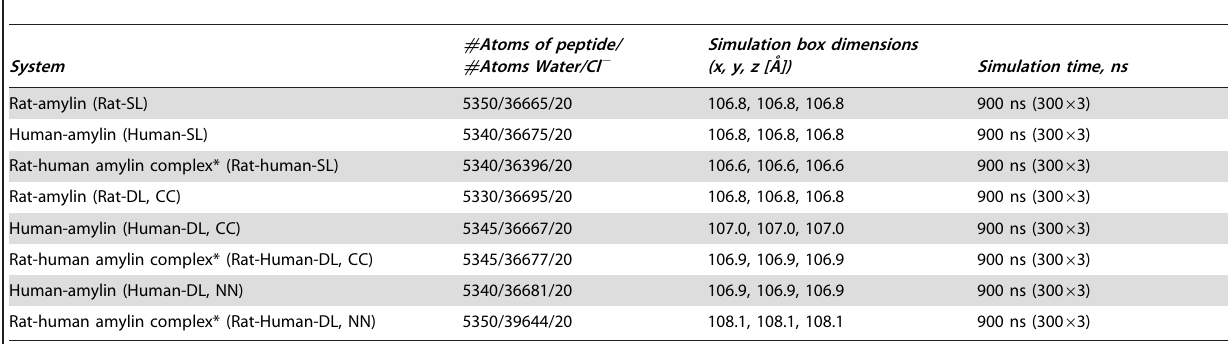
Table 1. Single layer and double layer decamer models and simulations conditions.